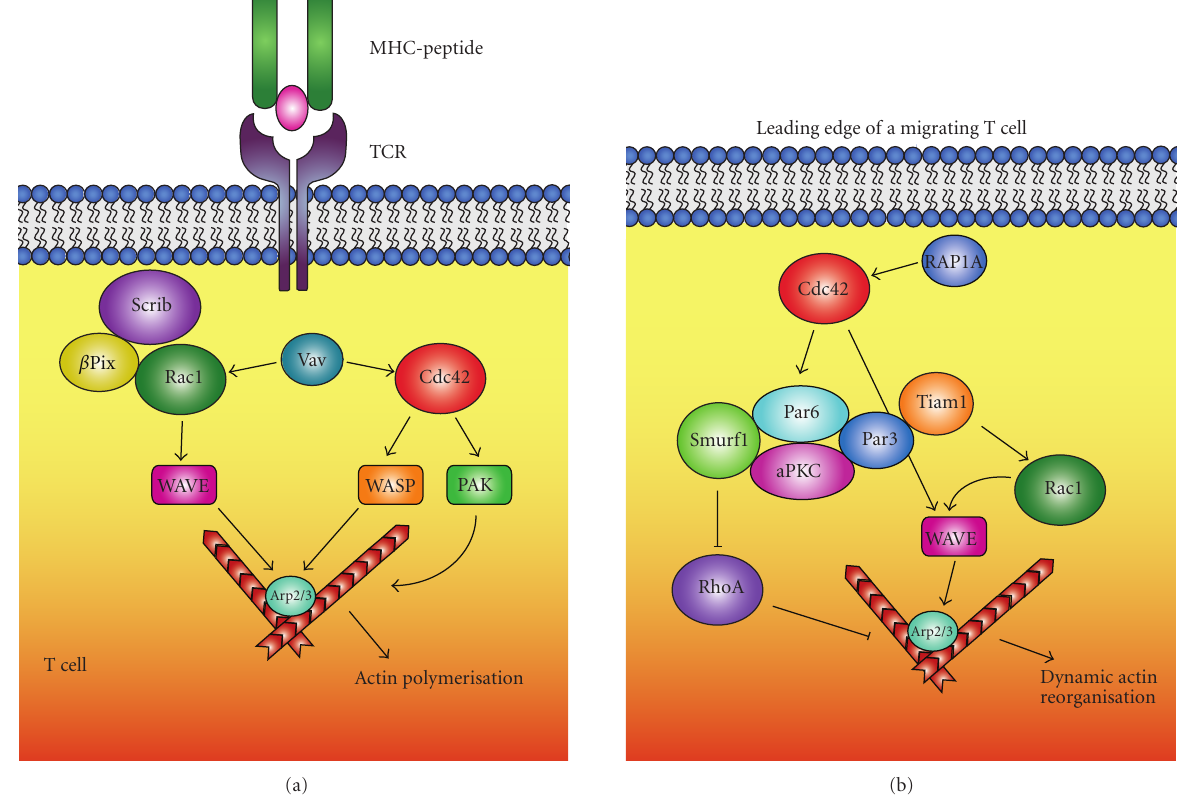
Figure 1: GTPases are important mechanical switches in T-lymphocyte function. (a) During antigen presentation, a T-cell undergoes dramatic changes in protein localization and morphology. The polarity protein, Scribble, is believed to be recruited to the synapse after TCR signaling and, through its potential association with β PIX, may recruit Rac1 and Cdc42 to close proximity to GEFs such as Vav. Activated Rac1 and Cdc42 in turn, activate downstream e ff ectors such as WAVE, WASP, and PAK, enabling actin polymerization and thus, changes in morphology. (b) In a migrating T-cell, GTPases regulate actin polymerization to allow for cell moment. At the leading edge of the cell, Cdc42 is activated by the Ras-related protein RAP1a, which in turns activates members of the Par complex. Par3 recruits a RAC GEF, Tiam1, which in turn activates Rac1. Rac1 promotes actin reorganization, thus lamellipodium formation through proteins such as WAVE and Arp2/3. The Par complex also binds and activates the E3 ligase Smurf1. Smurf1 promotes degradation of another GTPase, RhoA, which, in its active form enables actin contractility in